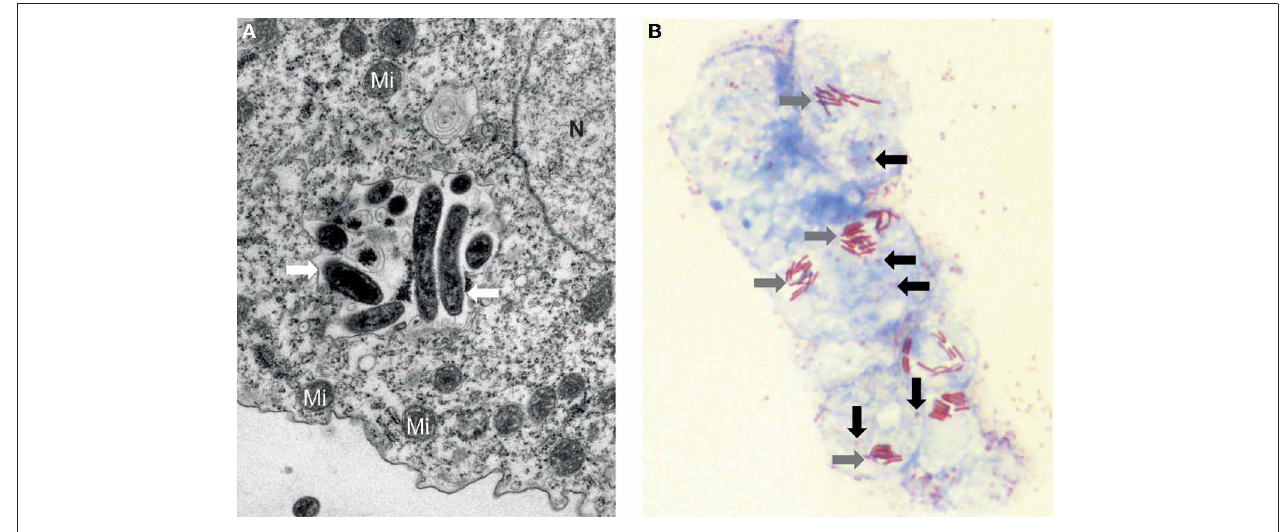
FIGURE 1 | Amoebae may hide several ARMs. (A) Electron microscopy of an inclusion containing a mixed population of microorganisms (white arrow) recovered from a water-humidifier co-cultured in an amoeba of the species Acanthamoeba castellanii . Mi: Mitochondrion, N: Nucleus. Magnification